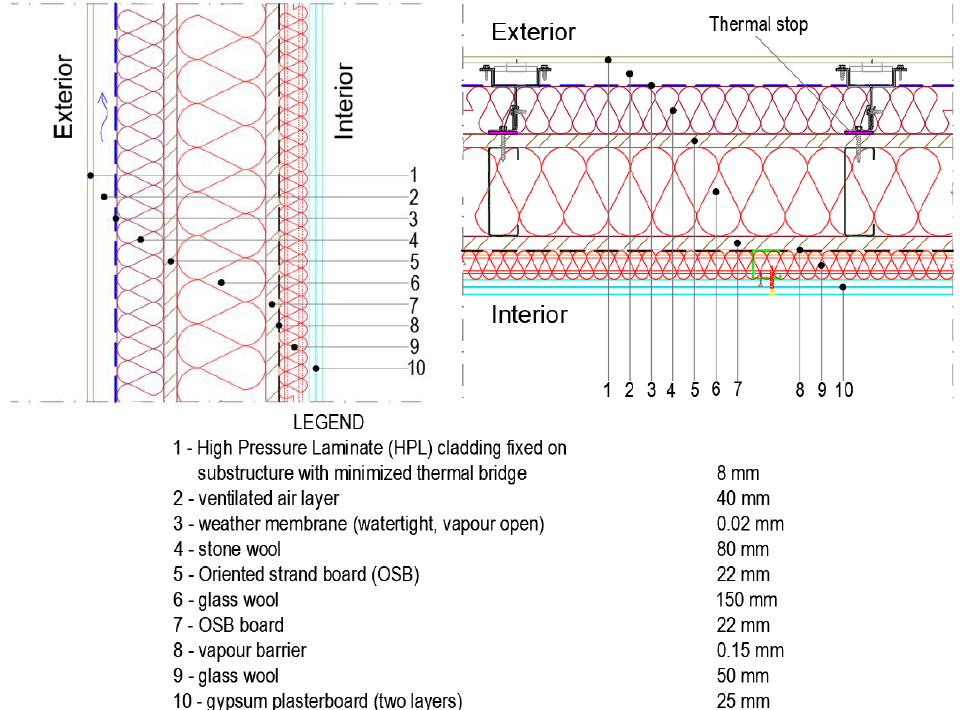
Figure 2. Proposed LSF wall structure ( left — vertical cross-section; right — horizontal cross-section).